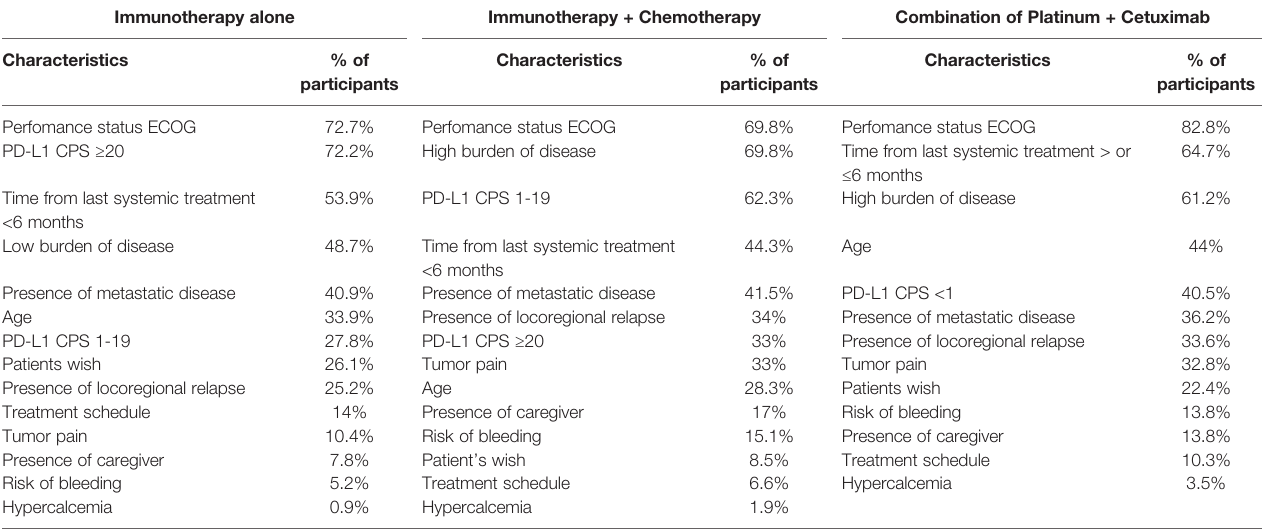
TABLE 2 | Factors that mostly in fl uence treatment decision.